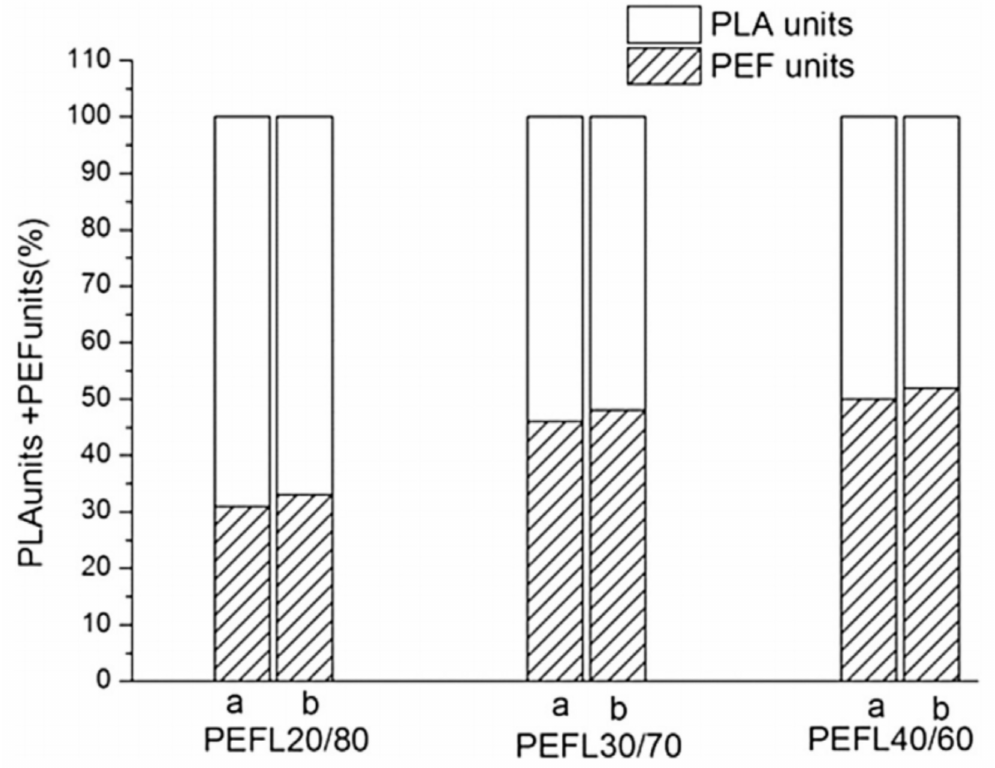
Figure 23. Mole fraction of lactide and furan units in soil before ( a ) and after ( b ) degradation